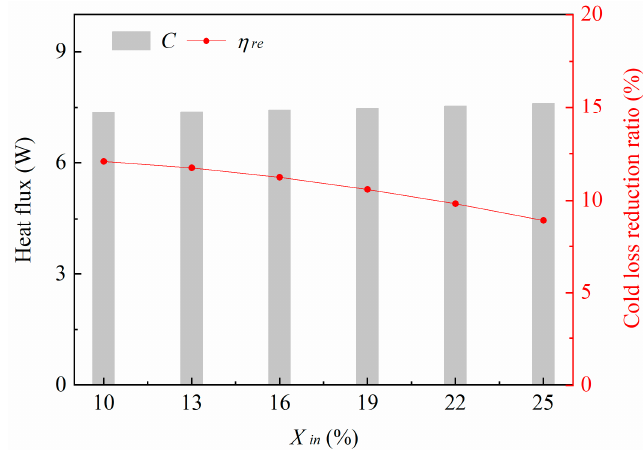
Figure 15. Overall cold loss of the modified freezer and cold loss reduction ratio versus X in .